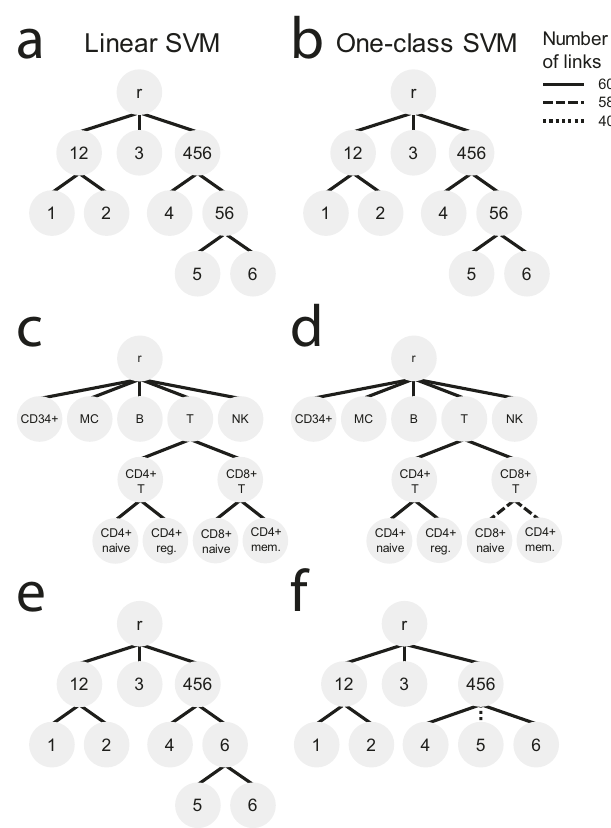
Fig. 4 Tree learning evaluation. Classi fi cation trees learned when using a a , c , e linear SVM or b , d , f one-class SVM during the a , b simulated, c , d PBMC-FACS, and e , f simulated rejection experiment. The line pattern of the links indicates how often that link was learned during the 60 training runs. d In 2/60 trees, the link between the CD8 + T cells and the CD8 + naive and CD4 + memory T cells is missing. In those trees, the CD8 + T cells and CD8 + naive T cells have a perfect match and the CD4 + memory T cells are missing from the tree. f In 20/60 trees, the link between “ Group456 ” and “ Group5 ” is missing. In those trees, these two populations are a perfect and mDC (which are actually CD16 + monocytes) as we would expect. Next, the CD14 + monocytes from the FACS dataset merge the CD16 + monocytes (which are actually mDC) and the